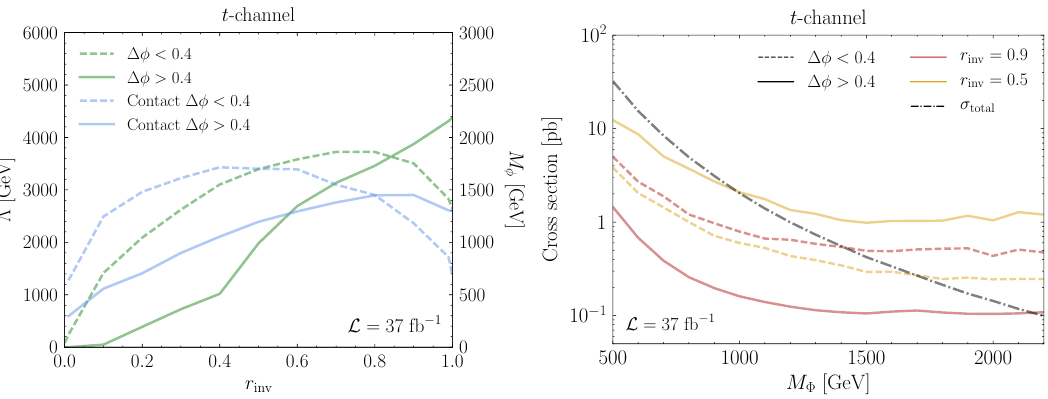
Figure 11 . (Left) Projected sensitivity on the operator scale or (cid:8) mass for the t -channel model with (cid:21) = 1. The solid green line shows the canonical (cid:1) (cid:30) > 0 : 4 cut in addition to the selection described in the text, while the dashed green line corresponds to the (cid:1) (cid:30) < 0 : 4 cut. Note that for r inv 0, a search strategy that does not have a minimum (cid:30) E T requirement should be investigated. ! The mapping onto the contact operator limit is (cid:3) = 2 M (cid:8) =(cid:21) . (Right) The 95% exclusion limits on the production cross section as a function of M (cid:8) for r inv = 0 : 9 (red) or 0 : 5 (yellow) corresponding to (cid:1) (cid:30) > 0 : 4 (solid) and (cid:1) (cid:30) < 0 : 4 (dashed). The total production cross section is shown as the dot-dashed black